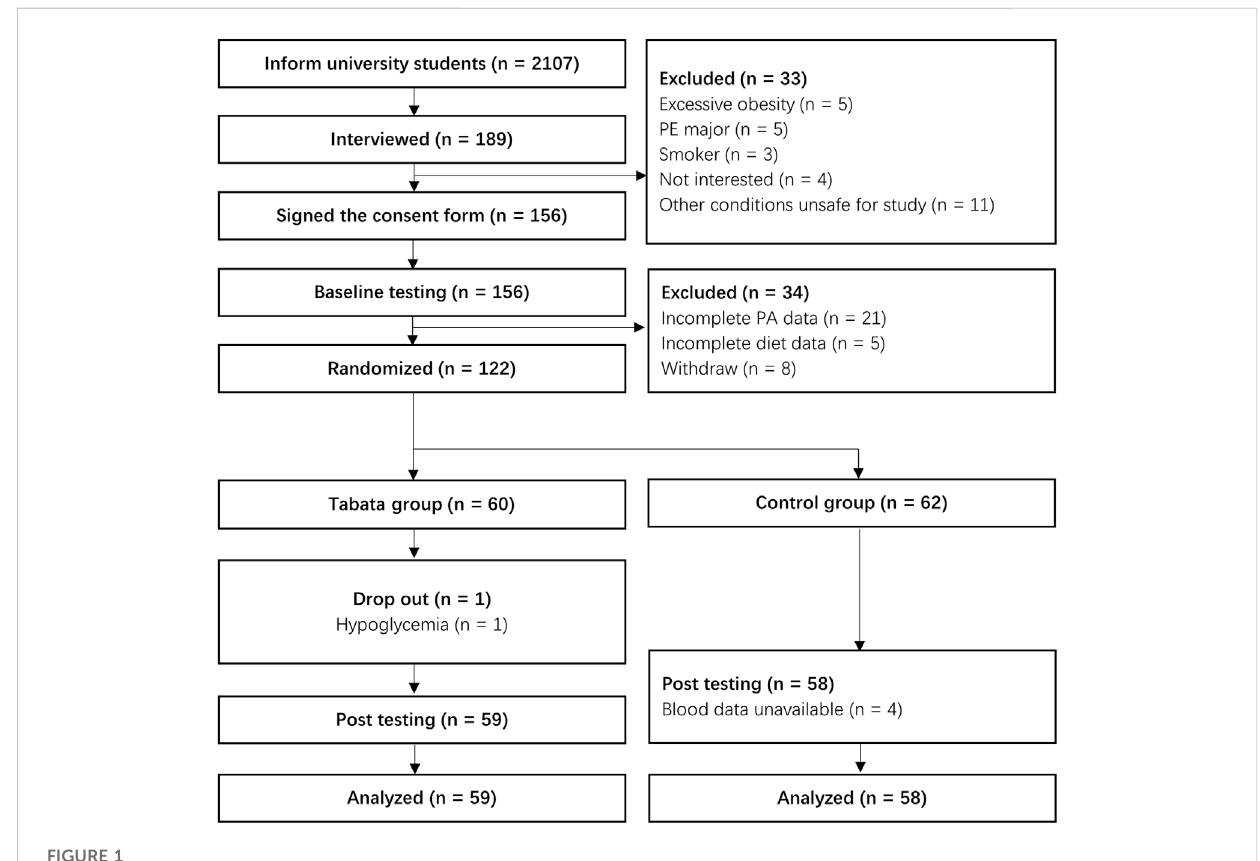
FIGURE 1 The process of sample and study